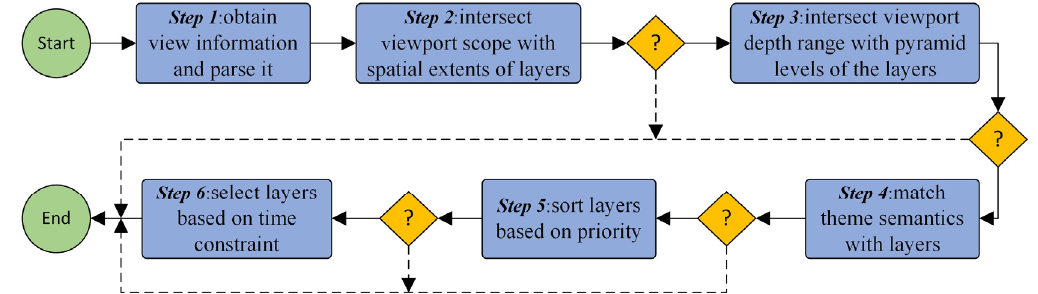
Figure 5. On-demand tile matching and filtering process.